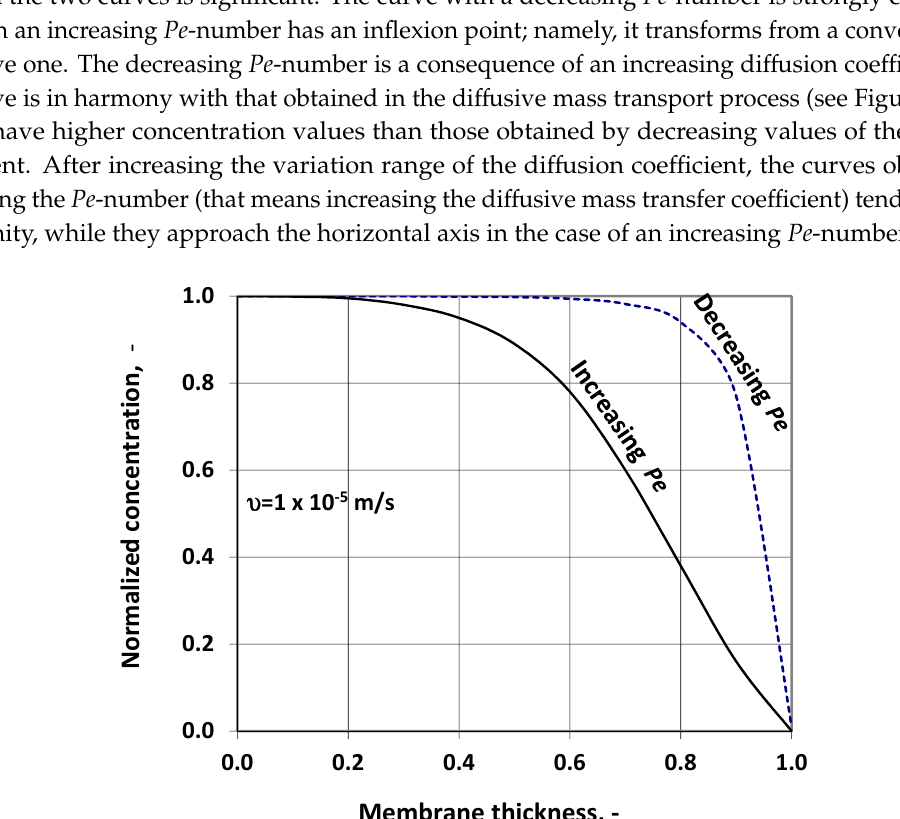
∗ = 0; Pe = ( 0.5 + 0.07 i ) 0.2 i δ